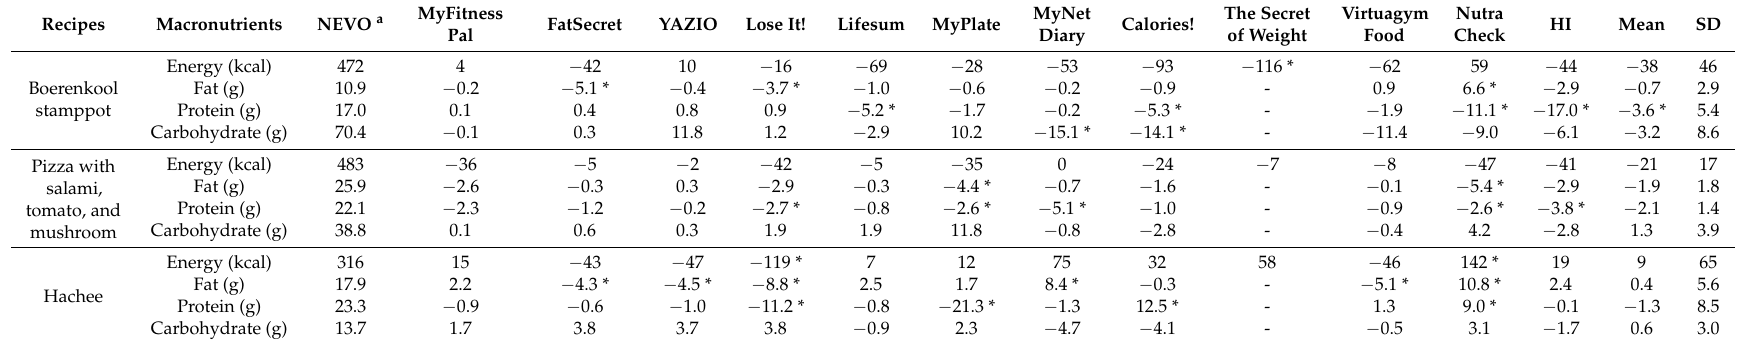
Table 4. Difference in energy (kcal) and macronutrient content (gram) estimations for one portion of each of three recipes between 12 dietary assessment apps and reference values using